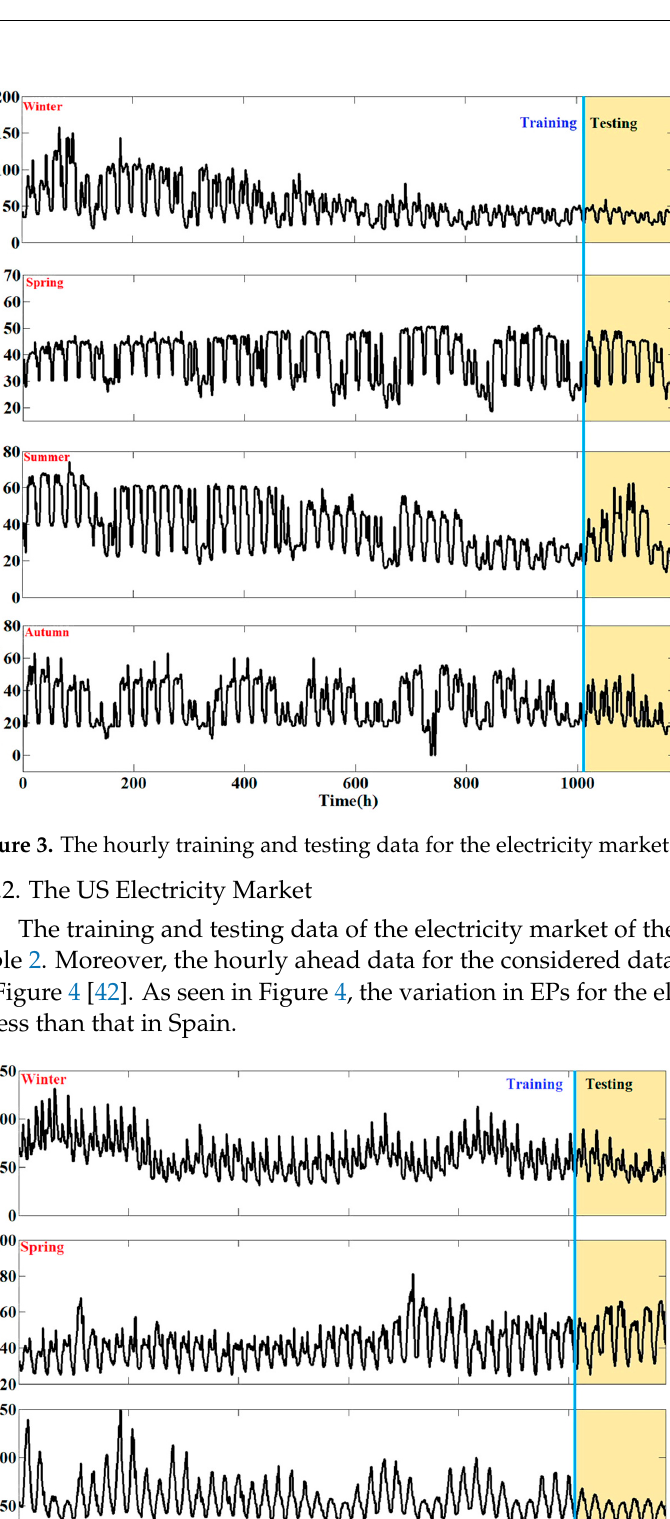
Figure 4. The hourly training and testing data for the electricity market of the US in 2018.